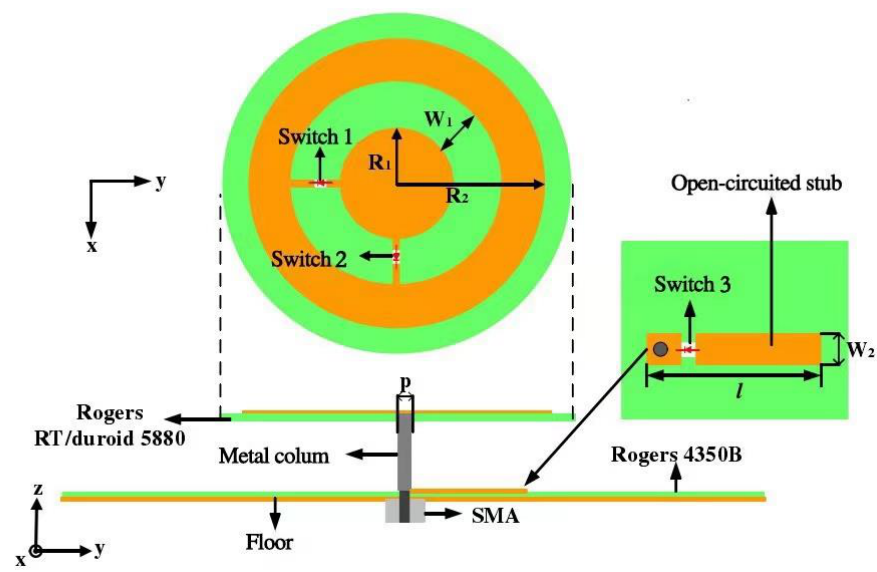
Figure 1. Reconfigurable antenna .